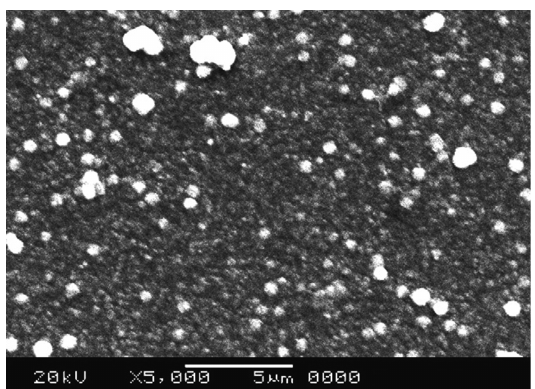
Figure 2. SEM Image of the CuSe thin